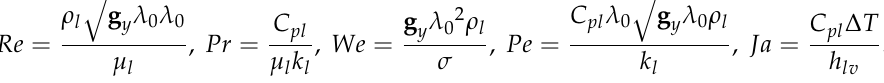
Table 2. Properties of the working fluid in simulations.